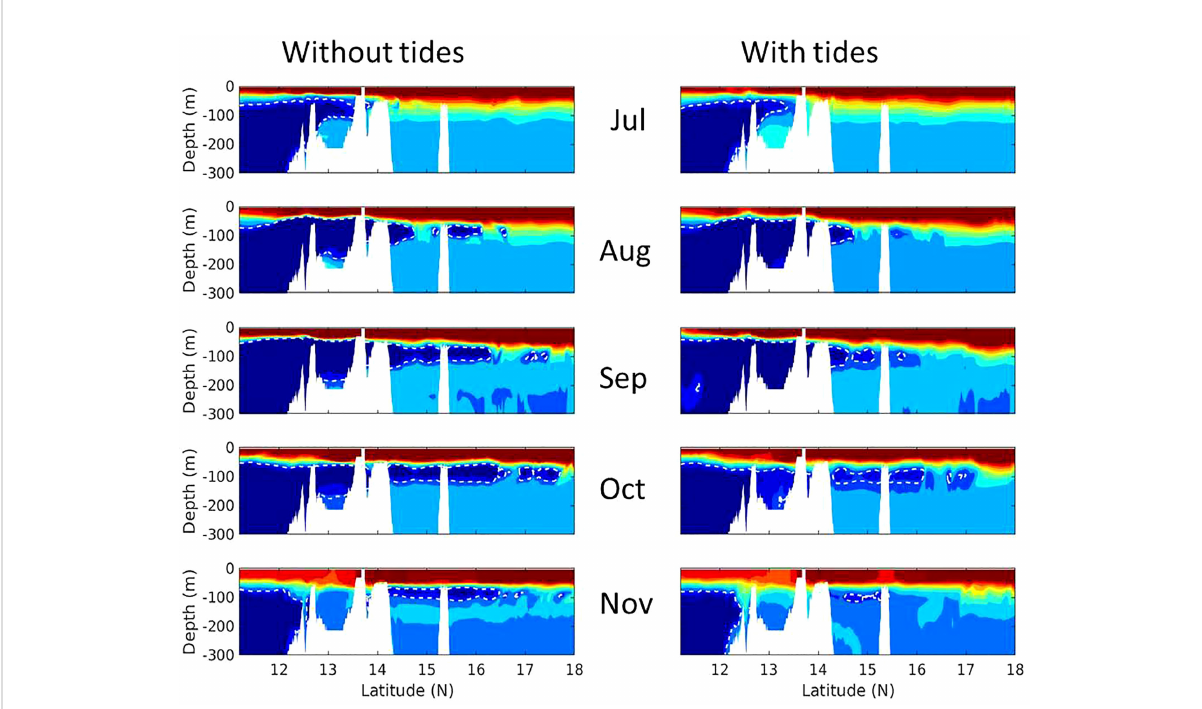
FIGURE 3 The comparisons of the along-axis extension of the summer intrusion of GAIW between the runs without tides (left panels) and with tides (right panels). The time variation of the monthly-mean potential temperature is shown from July (top) to November (bottom). The white dashed curves show the isotherms of 20°C as an indication of